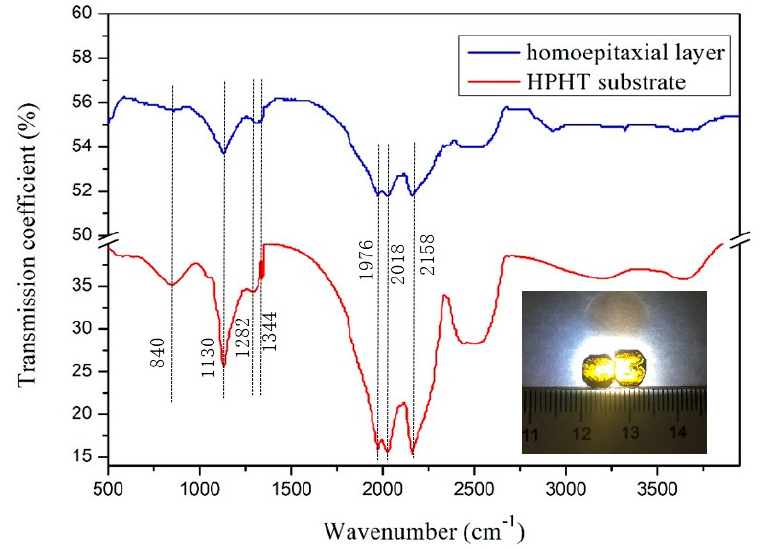
Figure 8. FTIR of the deposited CVD film and HPHT diamond substrate.